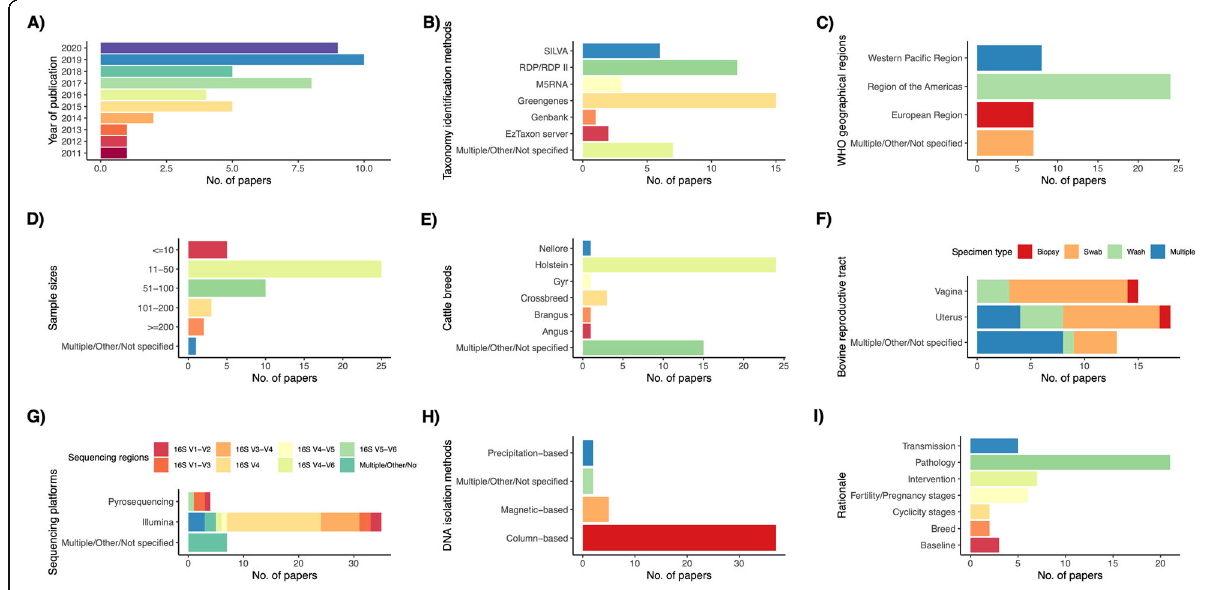
Fig. 3 Number of papers stratified into different categories in A ) year of publication, B ) taxonomy identification method, C ) WHO geographical region, D ) sample size, E ) cattle breed, F ) specimen type, G ) sequencing platform and sequencing region, H ) microbiome DNA isolation method and I) rationale. Papers were classified as “ Not specified ” when the metadata was not available, “ Multiple ” if multiple study designs